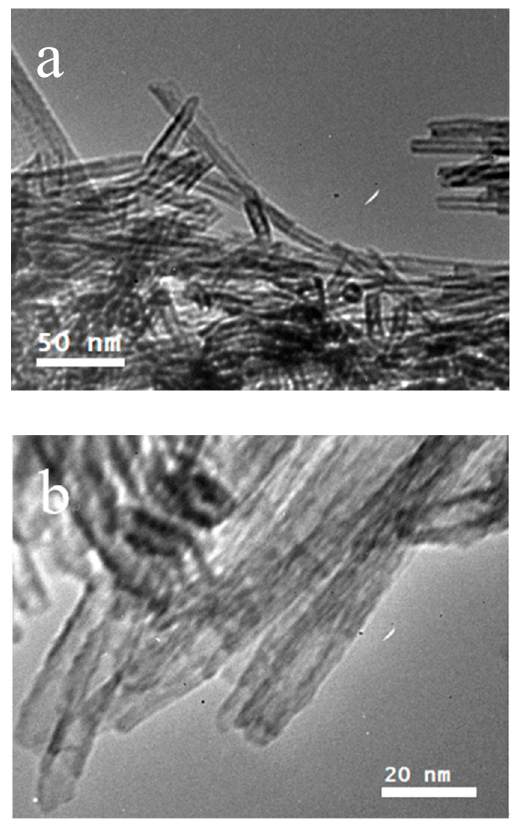
Figure 3. TEM (a) and HR ‐ TEM (b) images of HTNTs on Ti foils . Figure 3. TEM ( a ) and HR-TEM ( b ) images of HTNTs on Ti